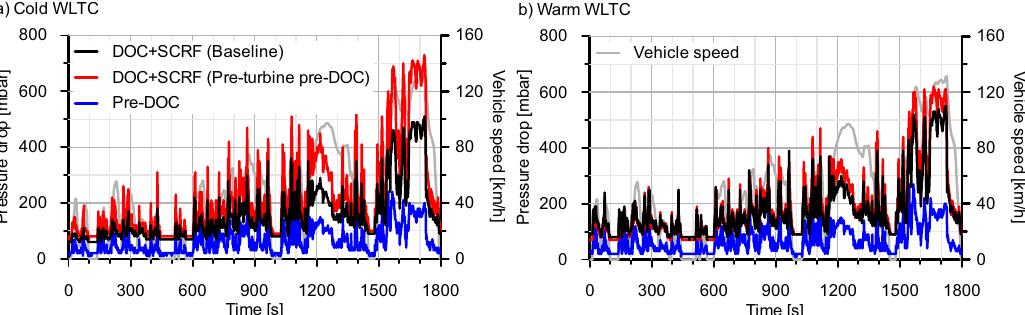
Figure 3. Pressure drop in DOC+SCRF and pre-turbine pre-DOC in ( a ) cold and ( b ) warm tests with baseline ATS and pre-turbine pre-DOC